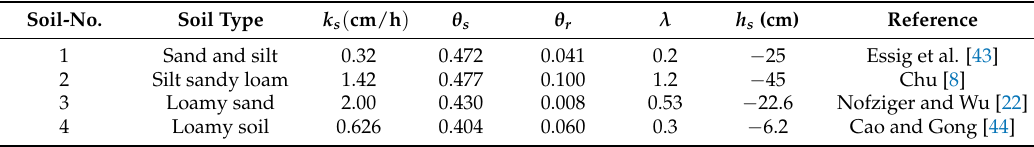
Table 1. The hydraulic parameters of the Brooks–Corey model.